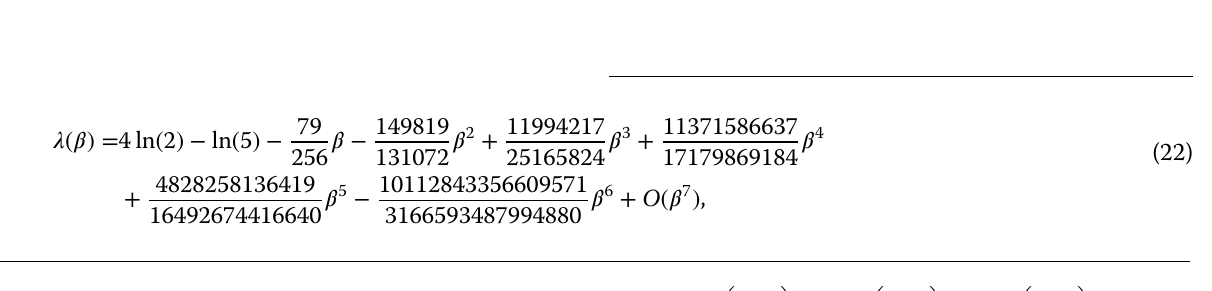
Fig. 1 (Color online) The dependence of the MLE on β for different probabilities p of taking the plus and minus sign in Eq. (19). (a) p p 0.2,0.8;(c) p 0.4,0.6;(d) the result for the system with Eq. (24). The Monte carlo results are marked with (blue) circles while the analytic = = approximation is plotted with (red) solid